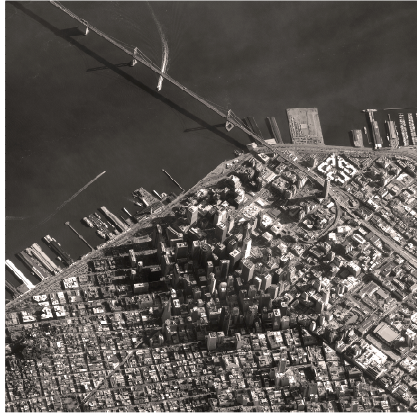
Figure 1 : Pleiades-HR image of San